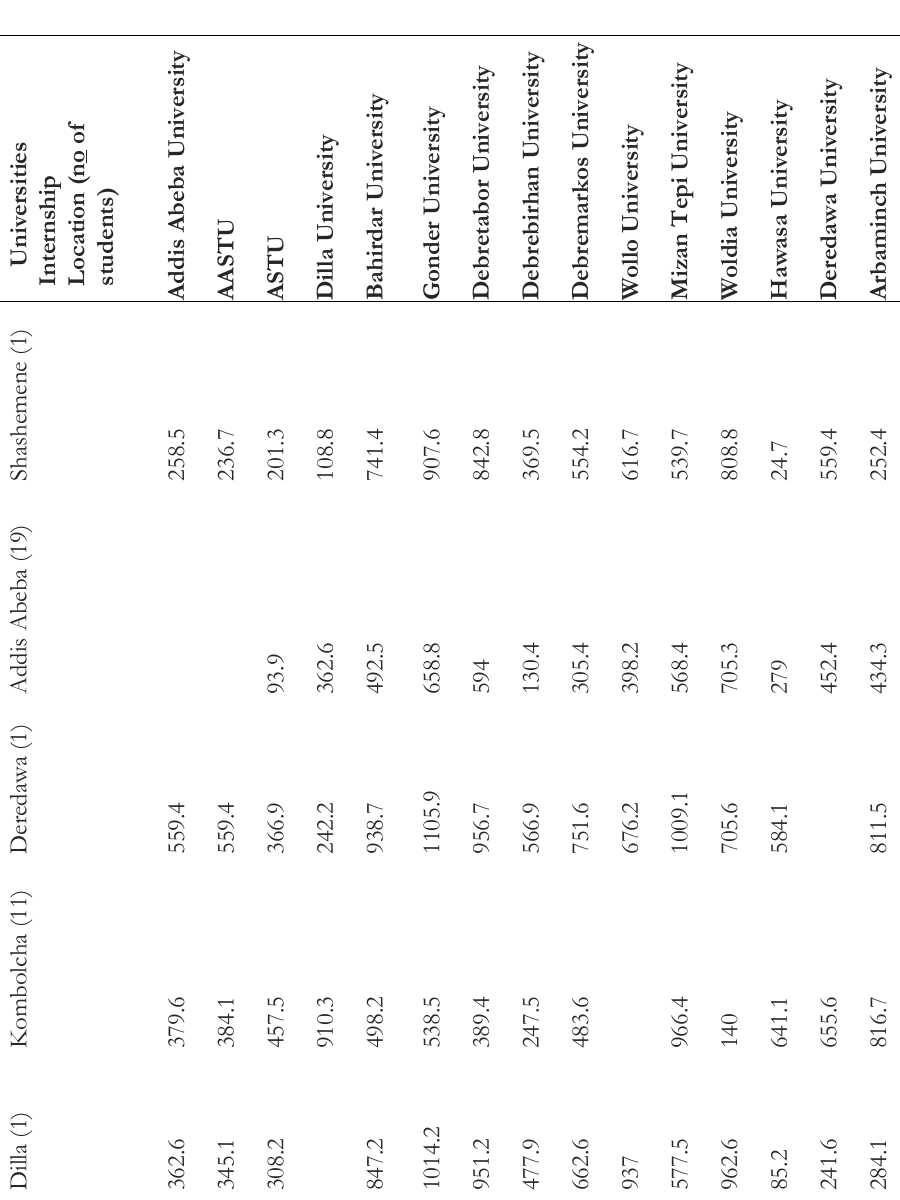
Table 1. Distance